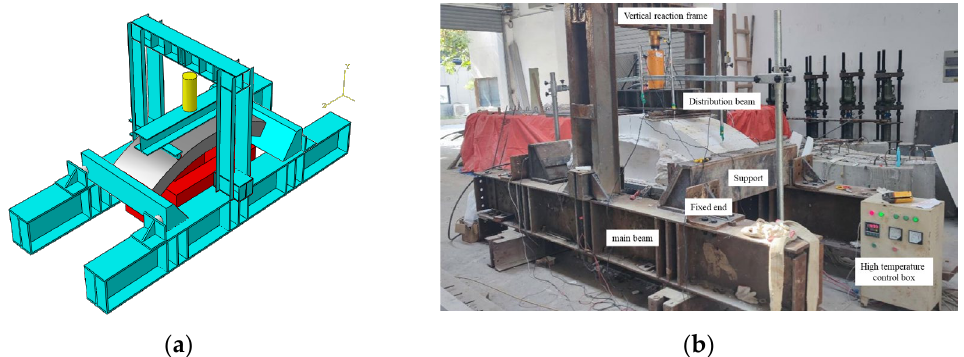
Figure 2. Test set-up diagram at high temperature: ( a ) Three-dimensional drawing of the test set-up; ( b ) Field drawings of the test set-up.